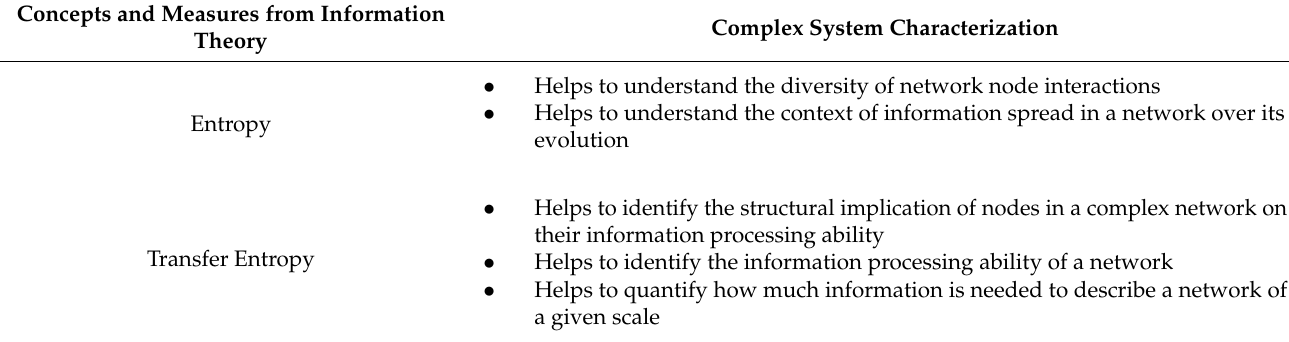
Table 8. Information theoretic concepts and their application towards complex